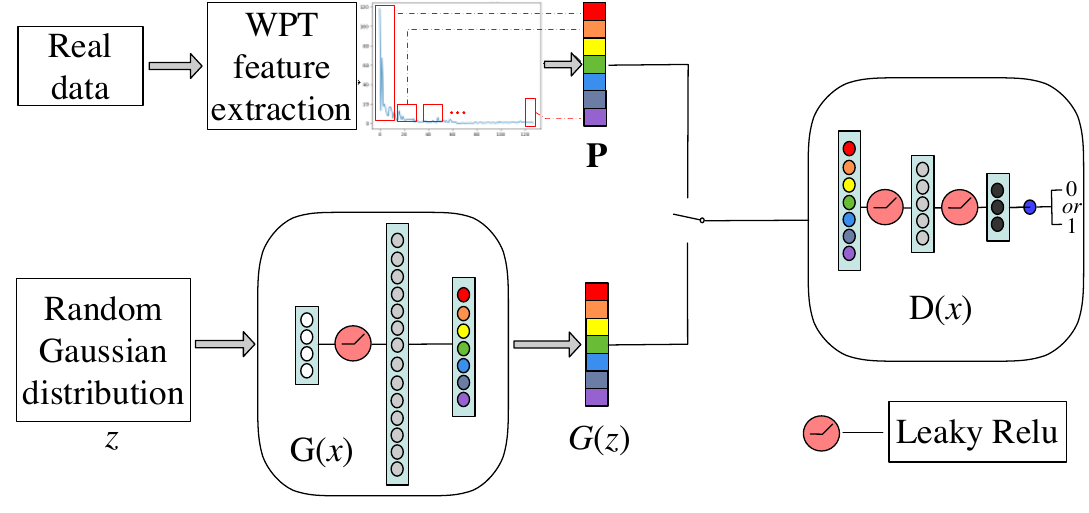
Figure 4. The learning scheme of the fault diagnoser.